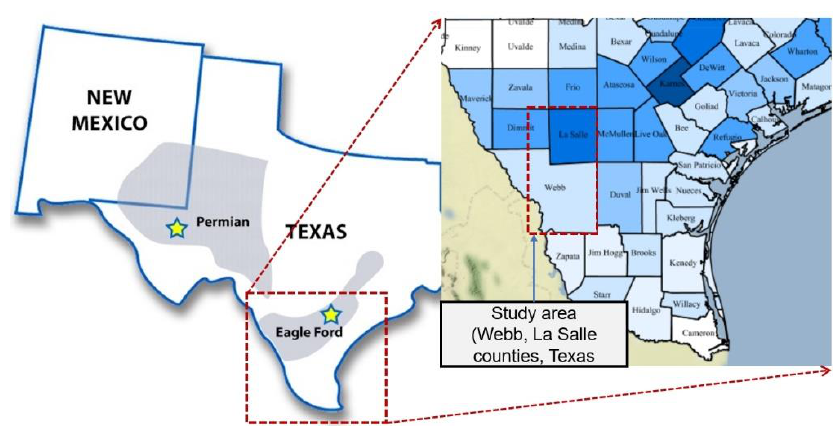
Figure 5. The study area of Eagle Ford shale reservoirs.